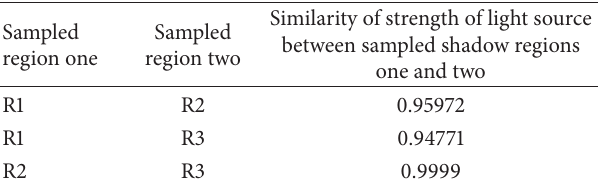
Table 2: Detection results on image in Figure